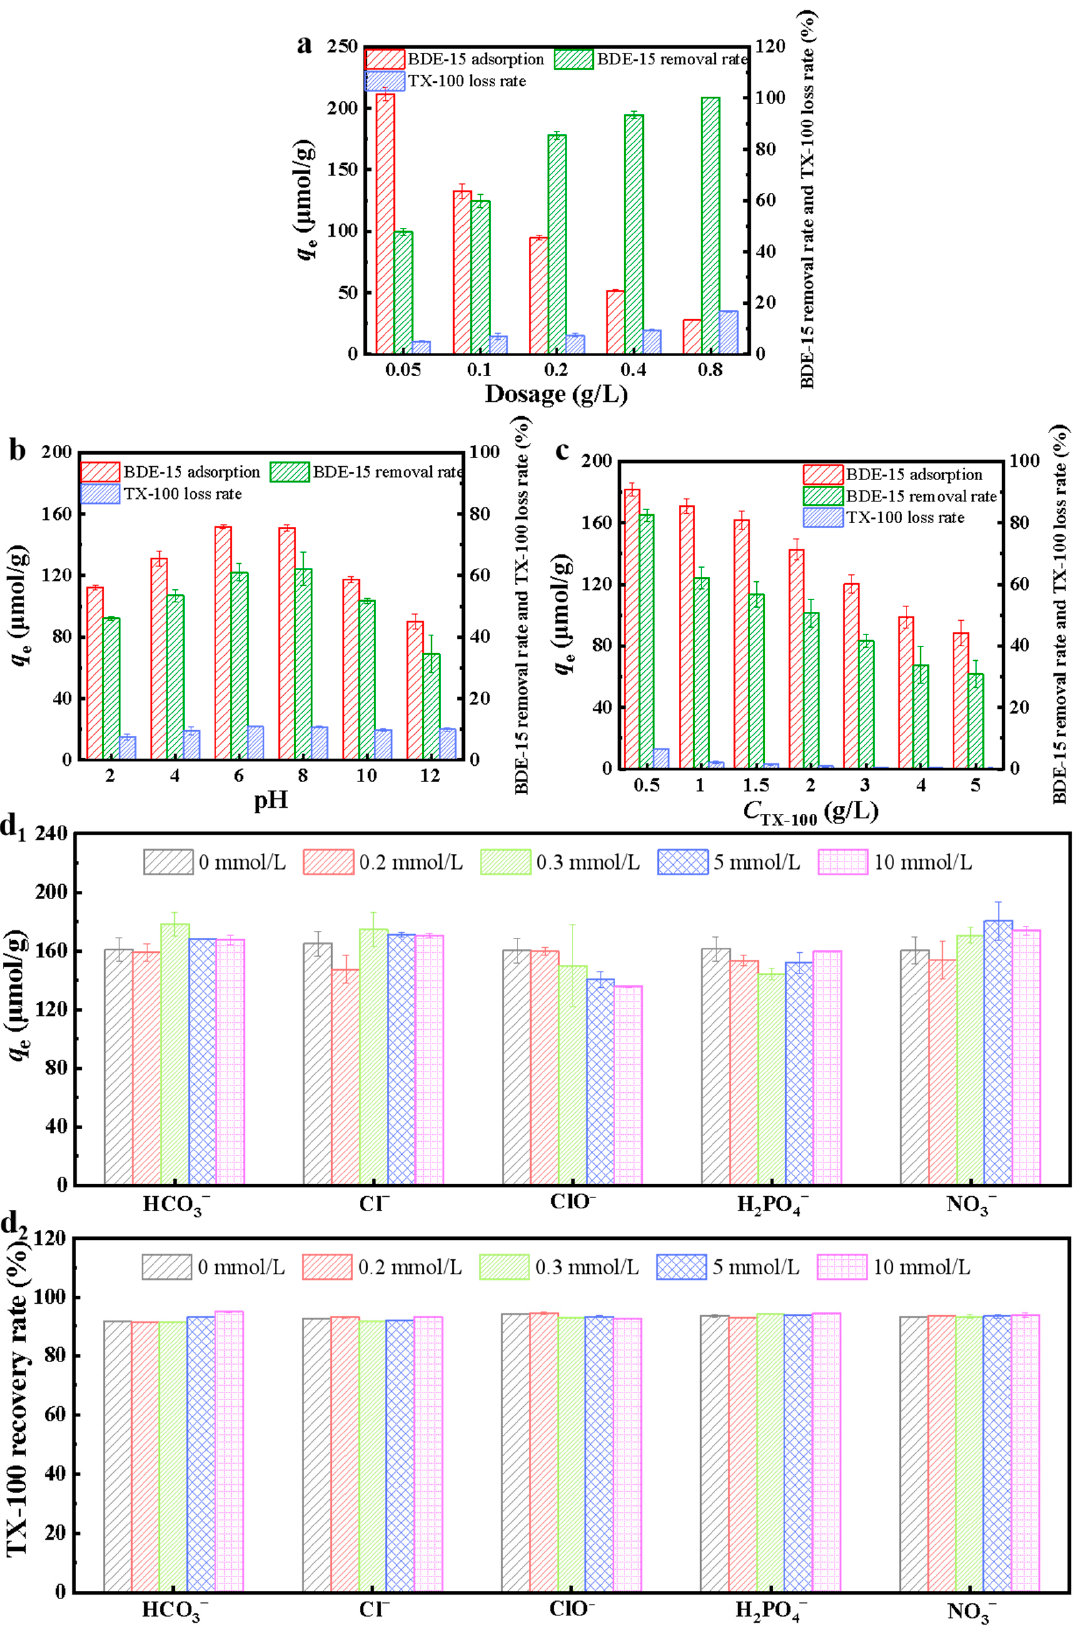
Figure 4. Influence of dosage ( a ), initial pH ( b ), C TX-100 ( c ) and environmental anions ( d 1 , d 2 ) on the adsorption.